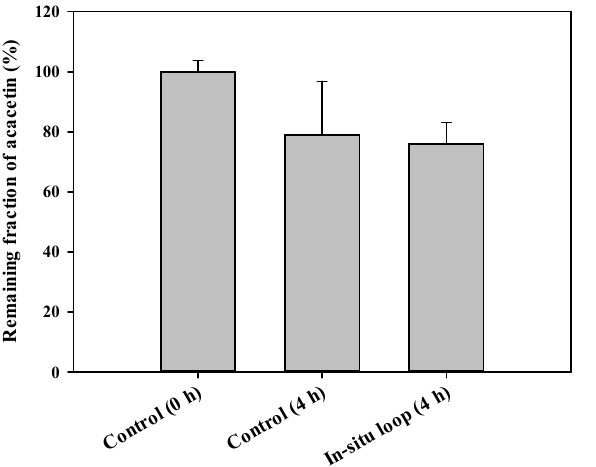
Figure 4. Remaining fractions of acacetin at 4 h after its injection into rat jejunum loops. The rectangular bars and error bars represent the means and standard deviations, respectively ( n = 3).